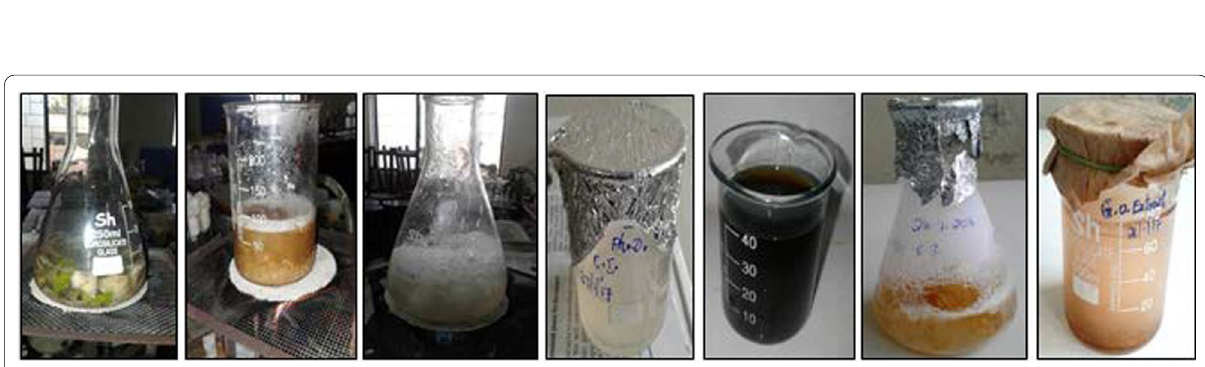
Fig. 2 Hot extraction, cold extraction, methanolic extraction, stored extracts at